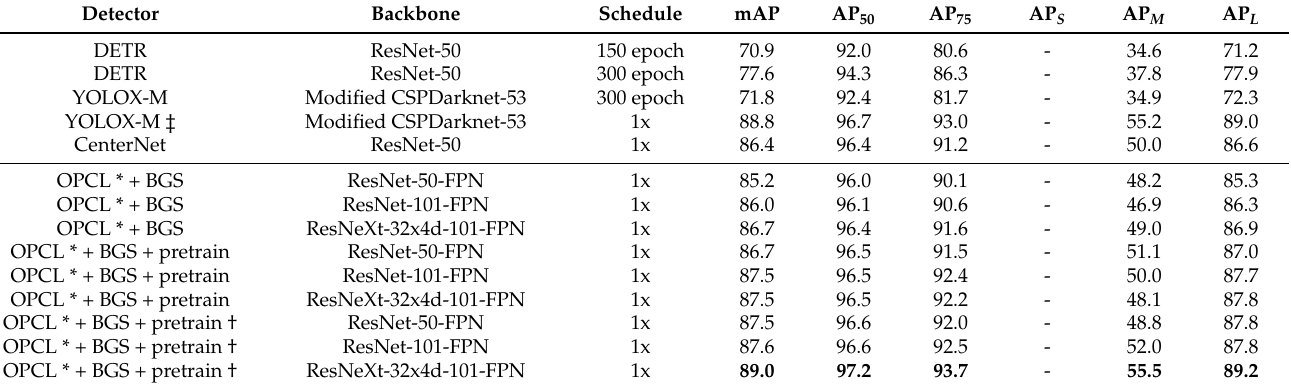
Table 10. Main results of RetinaNet with all our proposed modules and other advanced detectors. “Pretrain” means pretraining identity model on OSCD and fine-tuning on LSCD with the image scale of [600, 1000] (“†” means the image scale is [800, 1333]). “‡” means fine-tuned from COCO dataset model. “1x” means the model was trained for total 12 epochs. The bold font is used to emphasize the best performance according to the comments of the reviewers. In AP S item, this was on the corresponding value because SCD are on small instances in the evaluation framework of MS COCO. The symbol “*” means the gradient of OPCL with respect to IoU was computed during training.